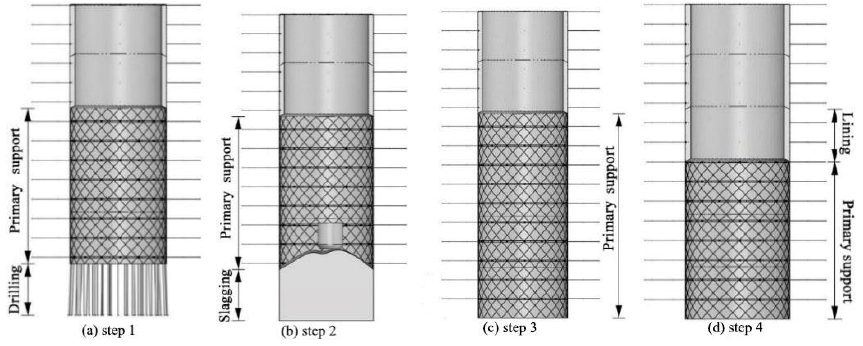
Figure 8. Schematic diagram of ASGR.